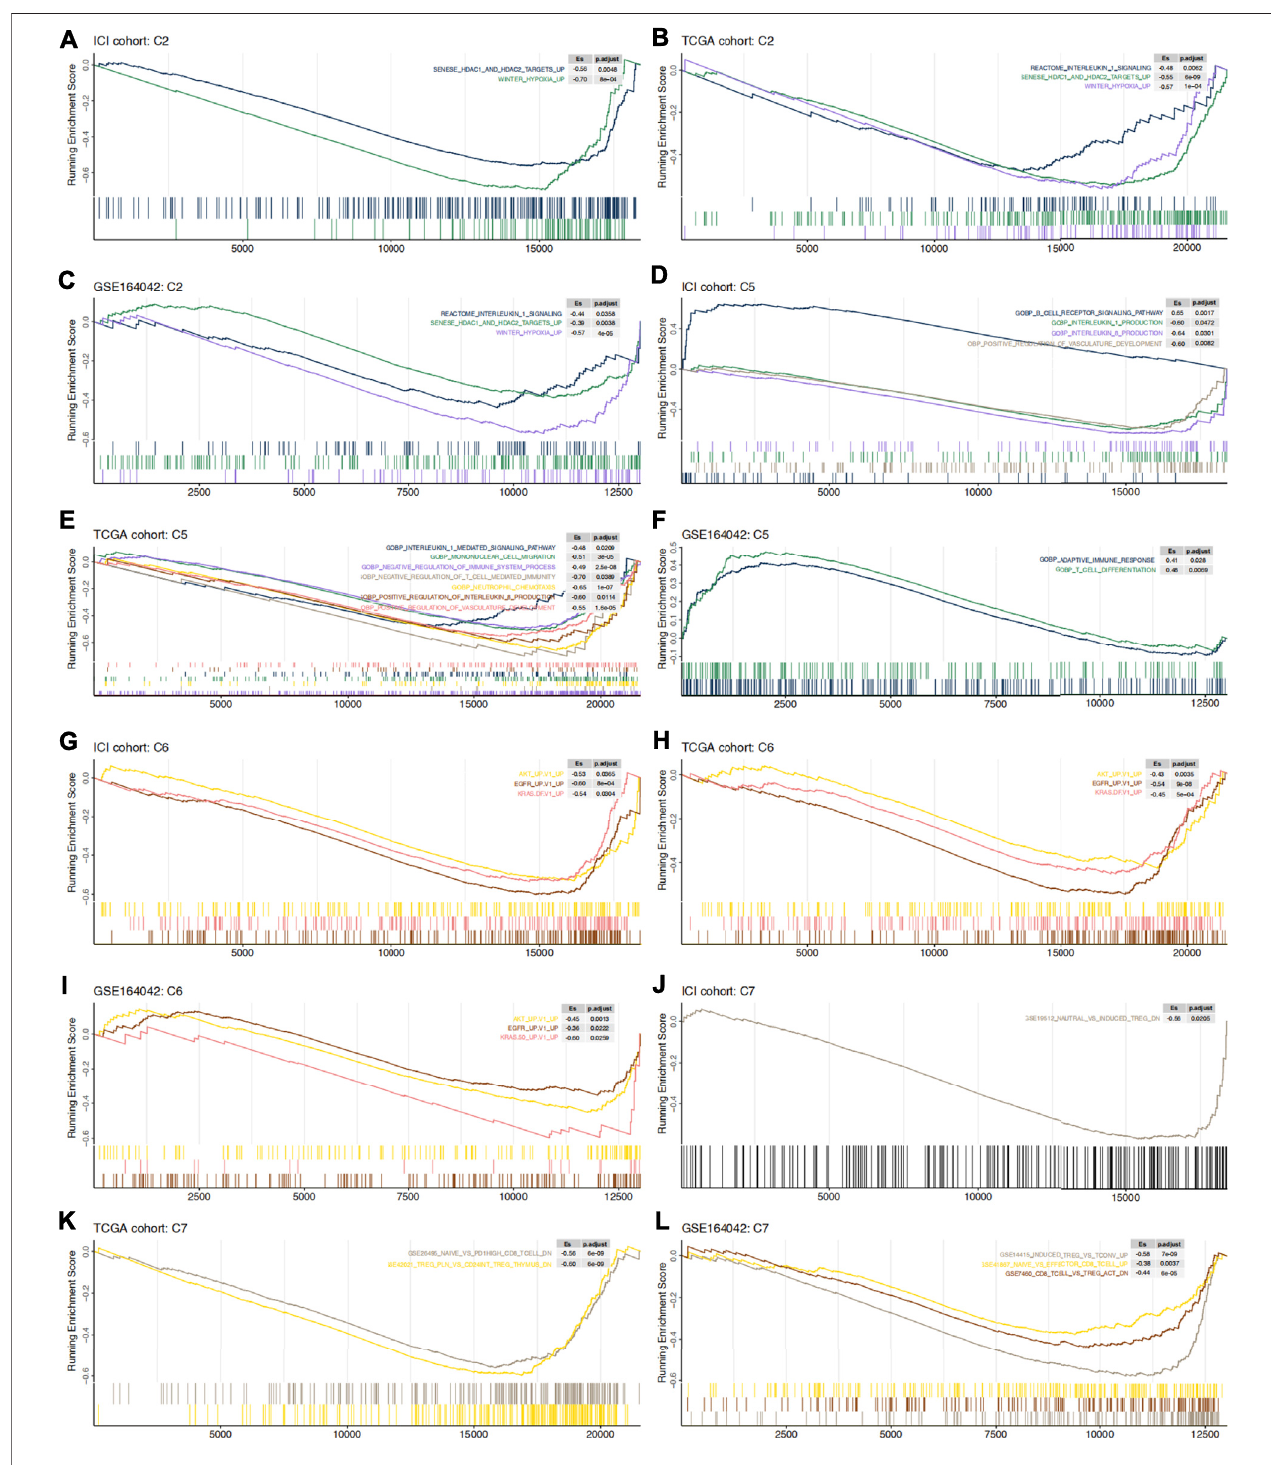
FIGURE 5 | C2 (A – C) , C5 (D – F) , C6 (G – I) and C7 (J – L) gene set enrichment analysis in ICI cohort, TCGA cohort and GSE164042 samples. High-GMS patients and GEO-control group served as the control group. ES > 0 means that the corresponding pathway is signi fi cantly enriched in low-GMS patients or GEO-KO samples, while ES < 0 is the